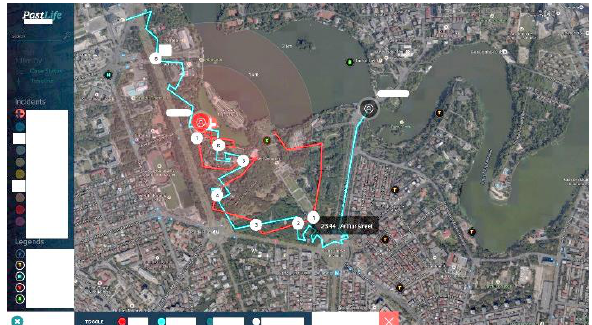
Figure 5. Representation of a patient’s crossing paths. A